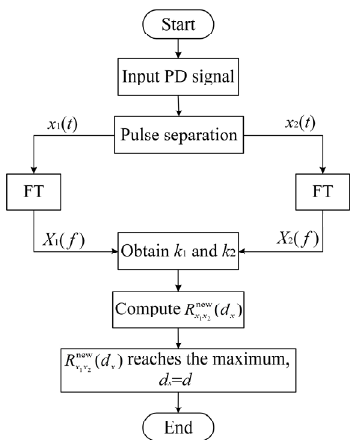
Figure 4. Block diagram of the proposed PD location algorithm based on distance.